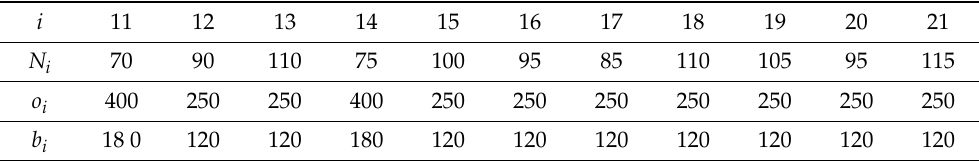
Table 9. Input values of constants N i , o i and b i for flights